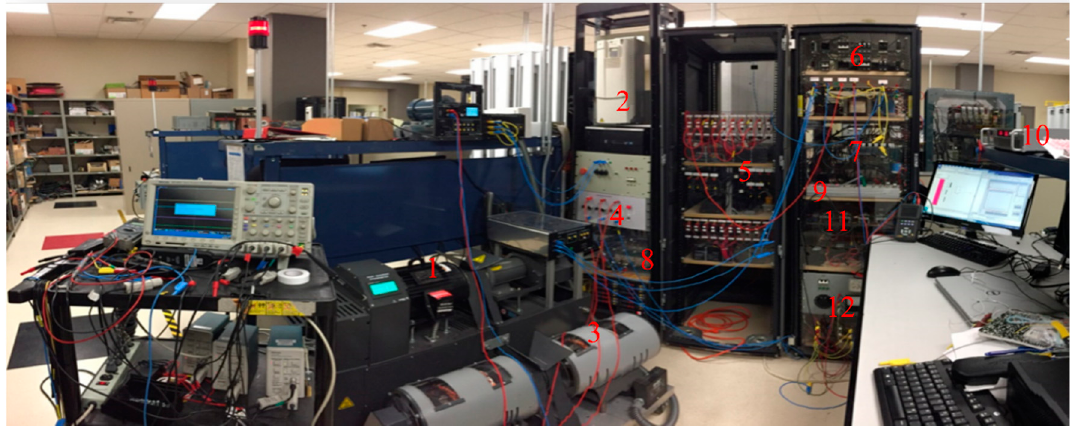
Figure 11. Hardware prototype.